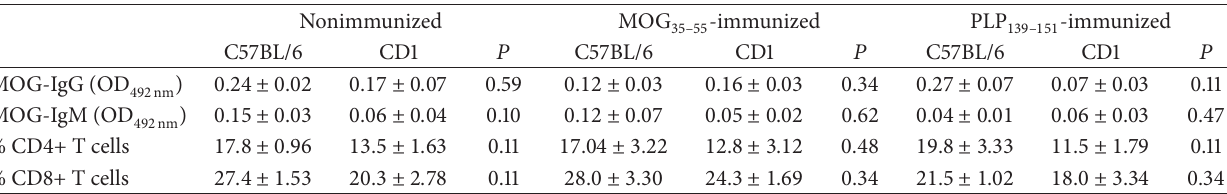
Table 1: Titers of anti-MOG serum antibodies and T cell and B cell percentages in spleen of mice resistant (CD1) and susceptible (C57BL/6) induced EAE. to MOG 35 – 55